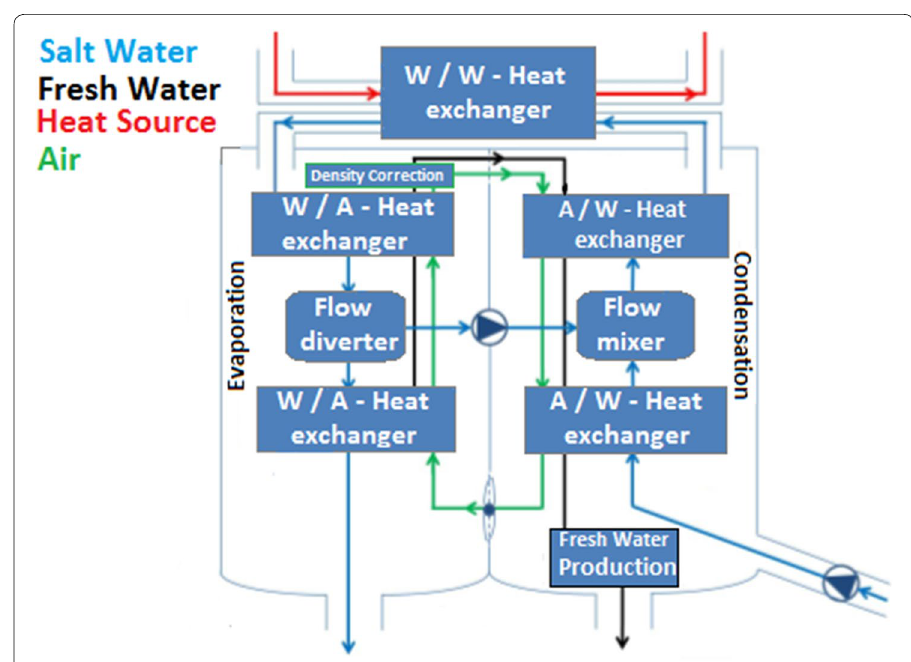
Fig. 2 Model of the WDU with all components